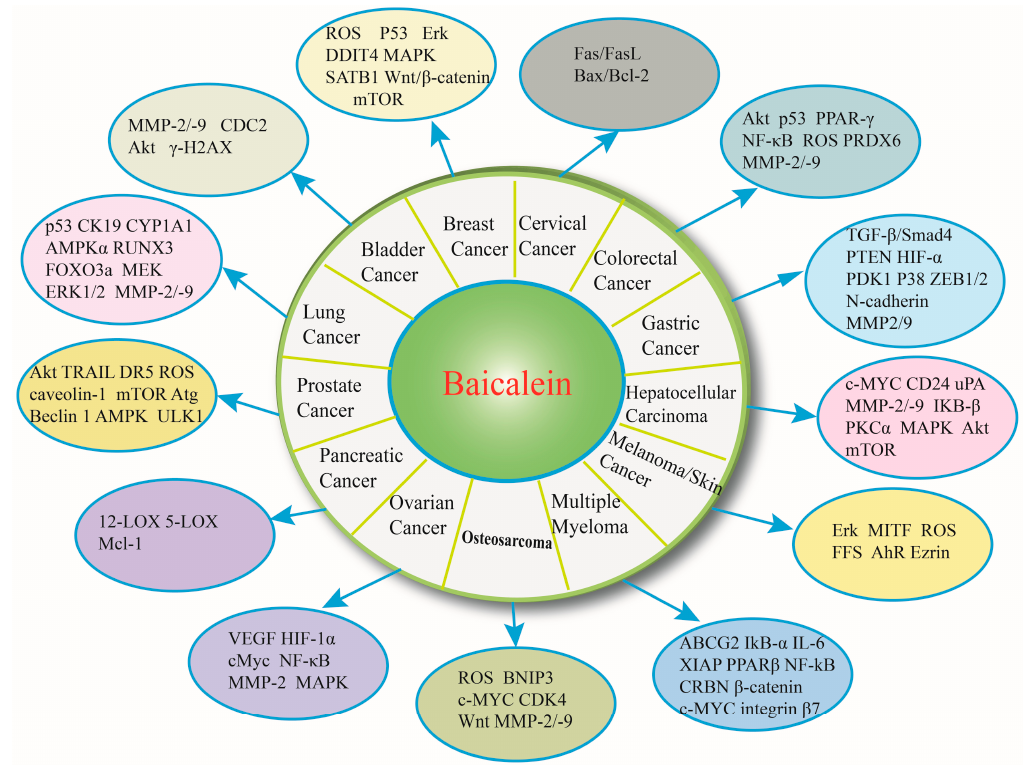
Figure 2. Baicalein inhibited various cancers through binding to and interacting with several molecular targets, such as Erk, ROS, MMP-2/-9, p53 and MAPK. These specific cellular targets which were involved in inhibiting various cancers are shown in Figure 2.